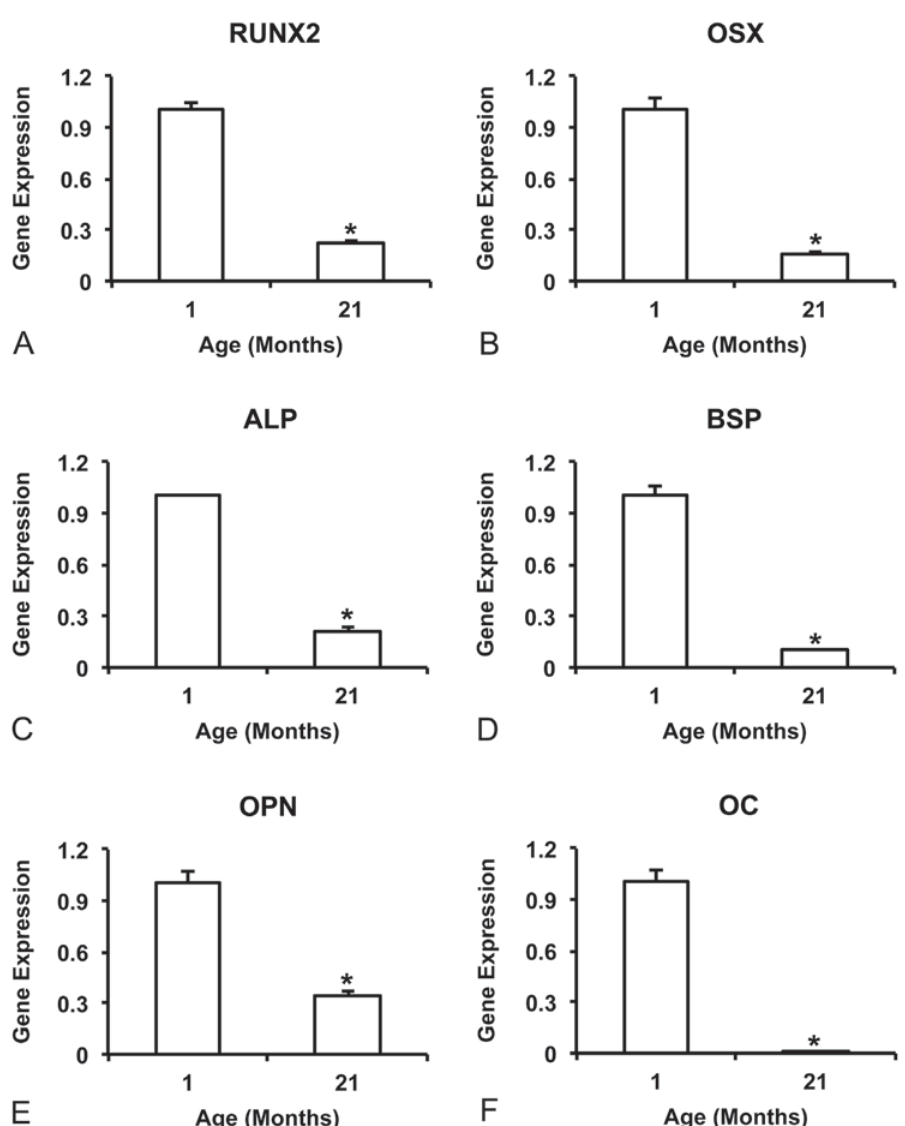
Figure 2- Gene expression at day 10 of the bone markers, RUNX2 (A), OSX (B), ALP (C), BSP (D), OPN (E), and OC (F) of cells from 1-month and 21-month rats grown on Ti discs. Data are presented as the mean±standard deviation (n=4). *